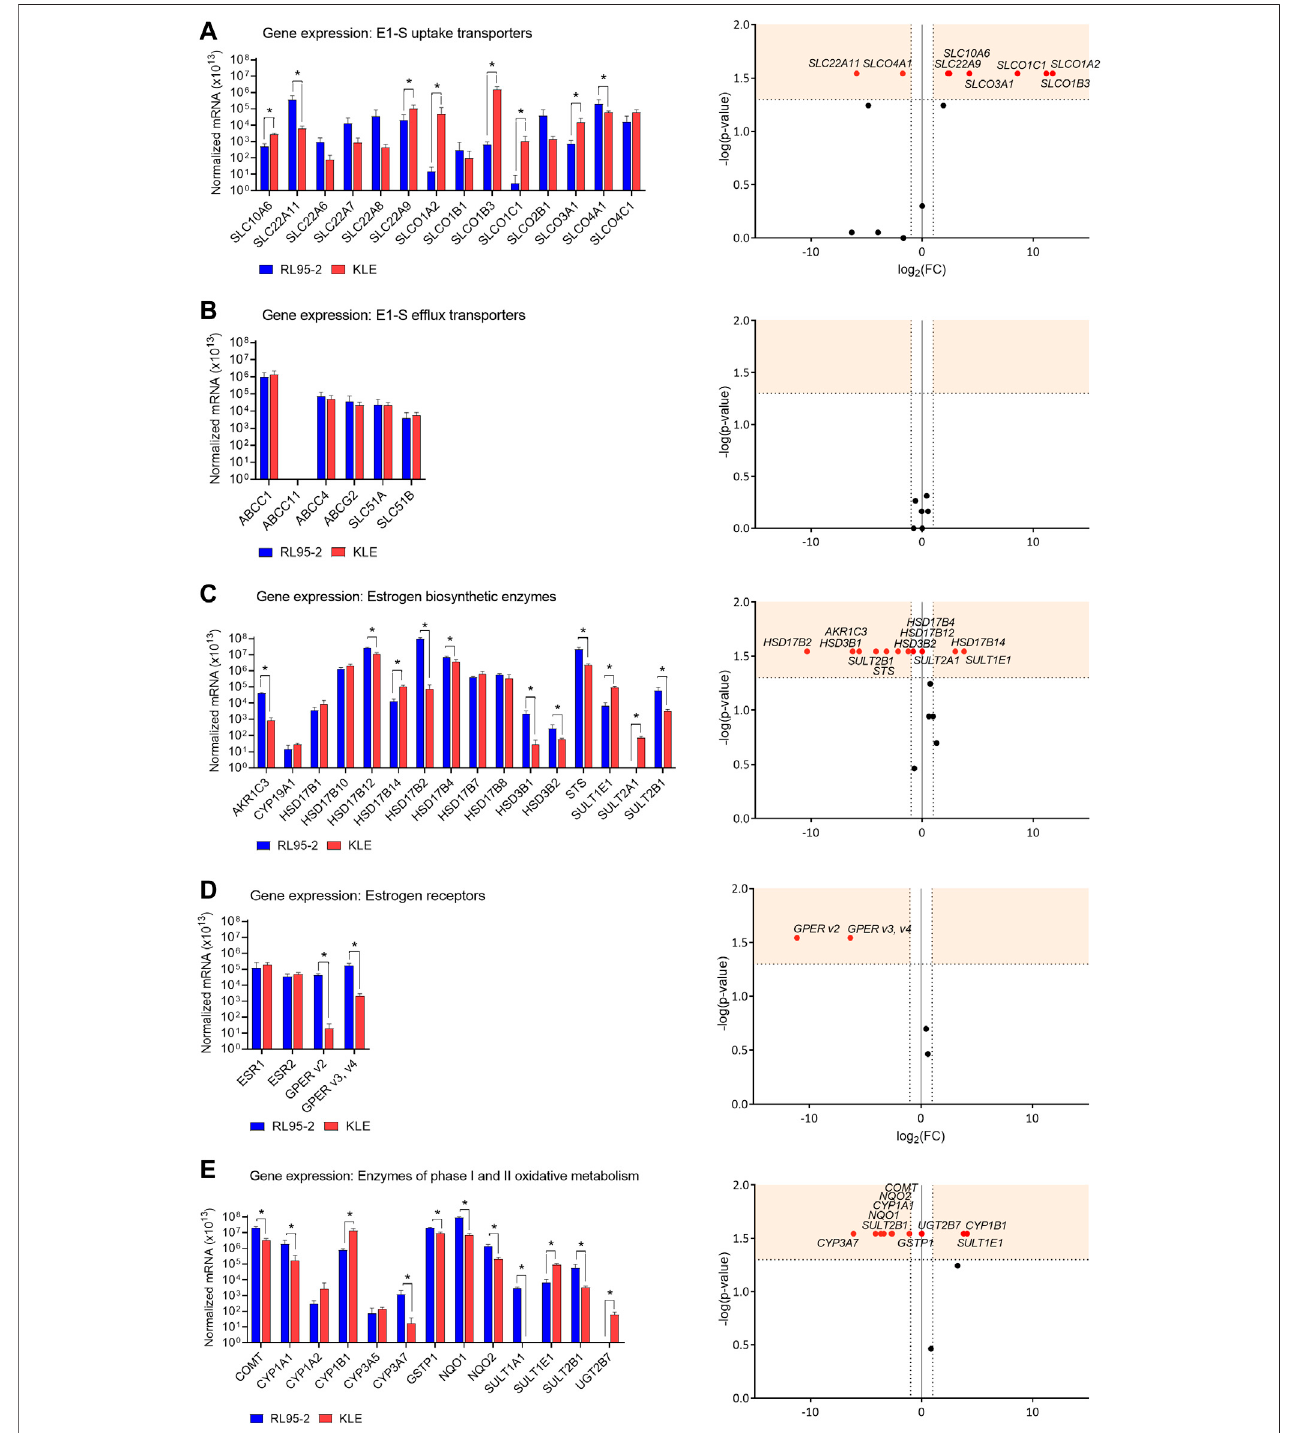
FIGURE1| ExpressionofgenesthatencodeE1-Suptake (A) andef fl ux (B) transporters,estrogenbiosyntheticenzymes (C) ,estrogenreceptors (D) andenzymes of phase I and II oxidative metabolism (E) . Left: Expression levels in RL95-2 and KLE cells, as normalized to the three reference genes, POLR2A, HPRT1 , and RPLP0 (n (cid:2) 4). *, p < 0.05 (Mann – Whitney tests). Right: Volcano plots for relative expression of the genes (KLE vs RL95-2 cells). FC, fold change; horizontal dashed line, cut-off forexperimentalsigni fi cance (shaded; -log(1.3); p < 0.05);vertical dashed lines,cut-offforgenessimilarlyexpressed inbothcelllines (FC, ± 2.0);vertical line(x (cid:2) 0), genes not expressed in either cell line; red symbols, differentially expressed genes; black symbols, non-differentially expressed genes.